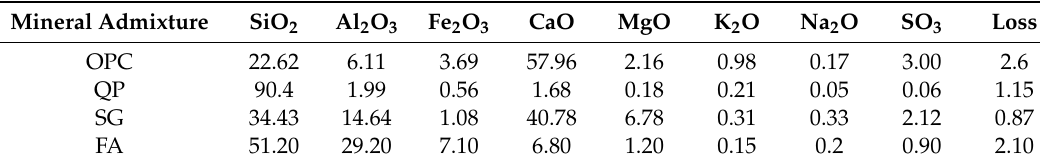
Table 2. Chemical composition of raw materials (wt.